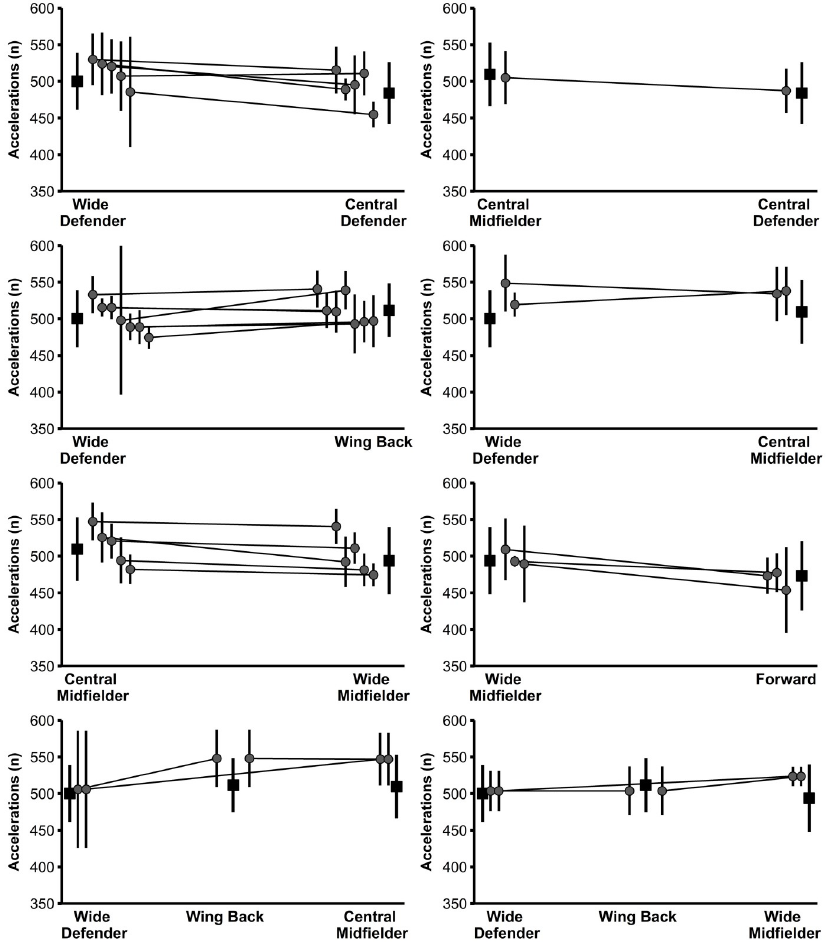
Fig 4. Number of accelerations of players from the study sample (grey diamonds and circles) in relation to normative positional data (black squares). Data are presented as mean values ± SD. Light grey diamonds and dashed lines indicate significant differences in performance between the two positions for the respective